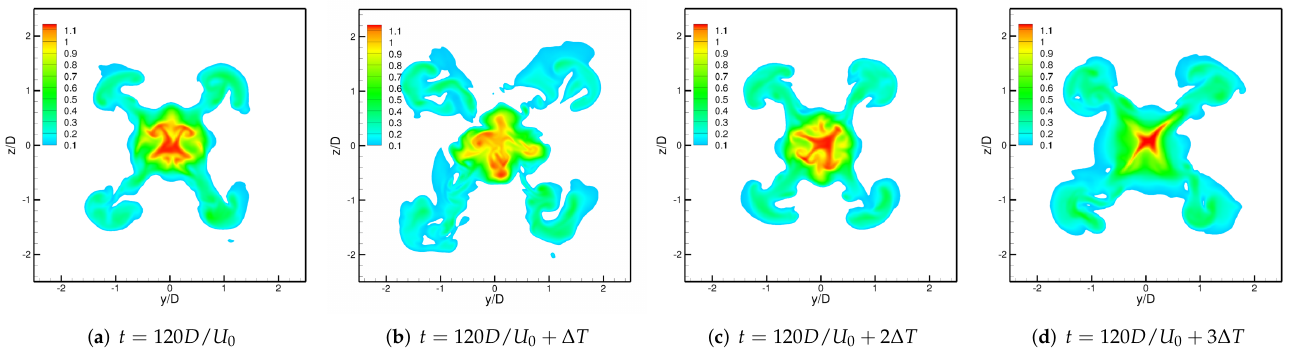
Figure 11. Contours of an instantaneous axial velocity U x / U 0 at the plane perpendicular to the jet axis x / D = 9 for the case E − Car − Ti 0.01